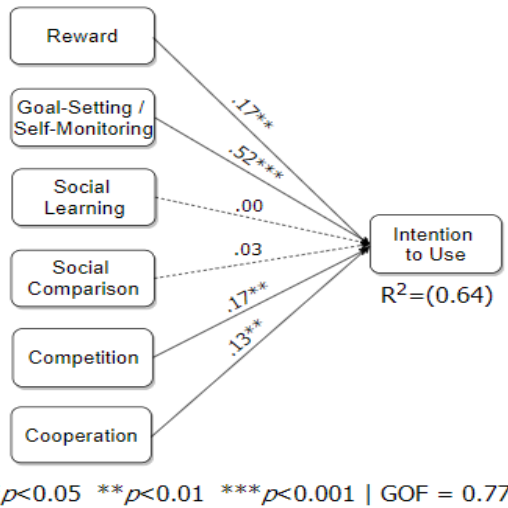
Figure 5. Global model of intention to use a fitness app .